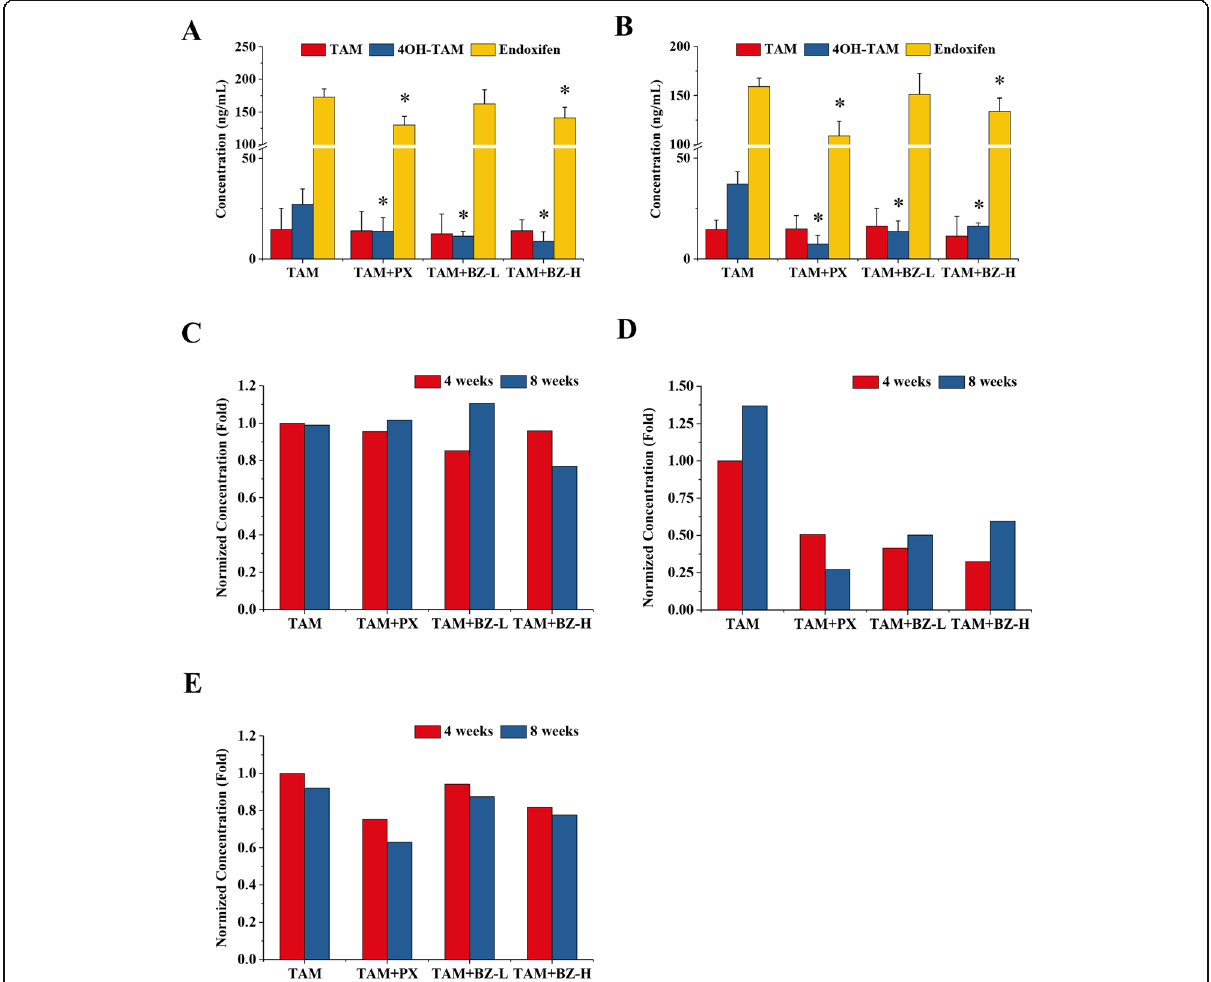
Fig. 3 Administration of BZ formula with tamoxifen decreased endoxifen and 4-OH-tamoxifen concentrations in tumor-bearing mice. Nude mice were injected with ER + human breast cancer MCF-7 cells and then treated with 4 mg/kg tamoxifen alone or in combination with BZ formula (2 or 8 g/kg) or paroxetine (4 mg/kg). The control group was treated with an equal volume of physiological saline. There were five animals per group. Blood was collected 1 h after oral administration on the last day of treatment and stored at -80 °C after centrifugation at 12000rpm for 10 min. The serum tamoxifen and endoxifen concentrations were measured using HPLC-MS/MS. The tamoxifen, endoxifen, and 4-OH-tamoxifen concentrations after a 4 and b 8 weeks. * p < 0.05 compared to the tamoxifen group based on one-way ANOVA. Normalized concentrations of c tamoxifen, d 4-OH-taxoxifen, and e endoxifen in the tamoxifen group after treatment for 4 and 8